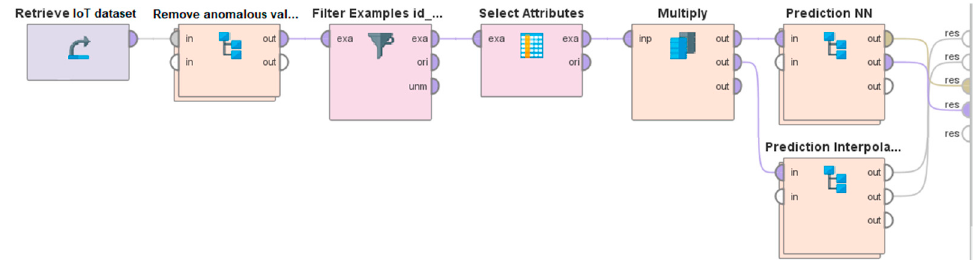
Figure 5. The workflow blocks on the IoT dataset featuring the two predictive models for the Task 3: the IoT sensors dataset is loaded, invalid and missing values are removed, there are filters to find the monitoring stations and the combination of their attributes, and finally the two machines learning sub-process blocks for the execution of the models.